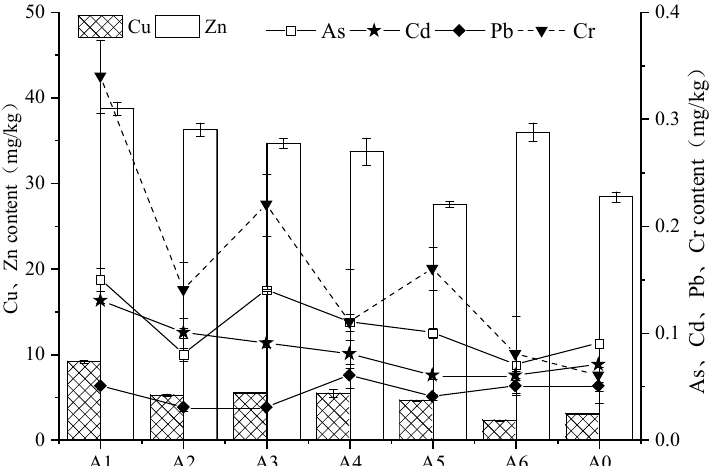
Figure 4. Changes in heavy metal content in middle oyster soft tissue at different monitoring stations (wet weight).